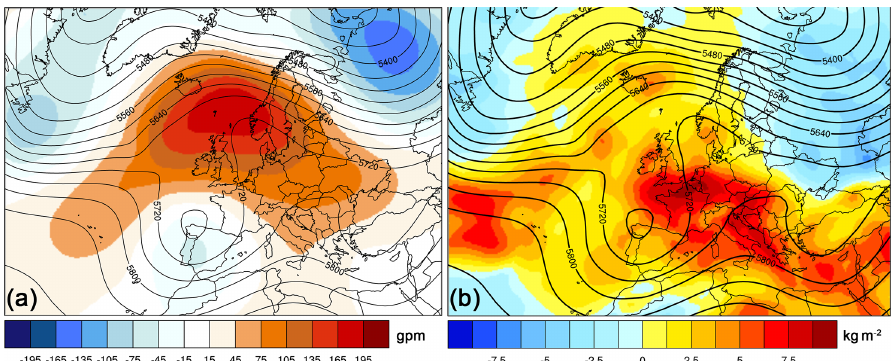
Figure 6. Mean anomalies during May–June 2018 of (a) 500hPa geopotential height anomaly (shaded in gpm) and (b) integrated water vapour anomaly (IWV; shaded in kgm − 2 ), together with the mean 500hPa geopotential height (contours every 40gpm). Anomalies are computed with respect to the climatology (1981–2001; based on